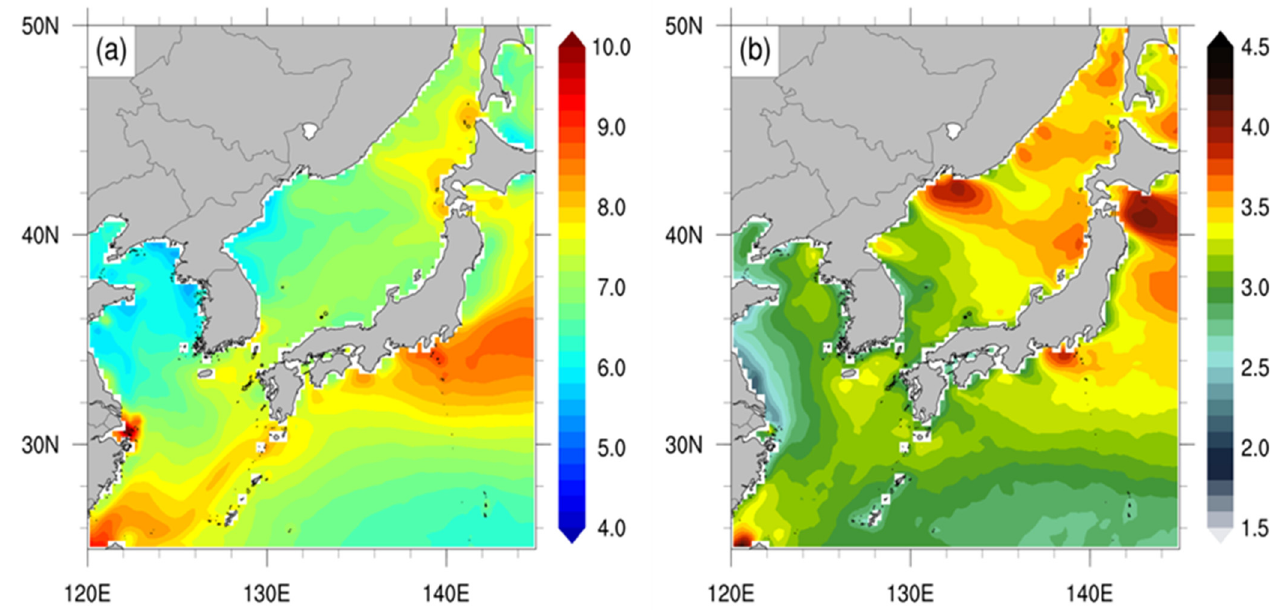
Figure 2. Spatial distribution of ( a ) annual mean wind speeds (m · s − 1 ) and ( b ) wind speed variability (m · s − 1 ) (standard deviation) based on DASCAT during 2008–2017.